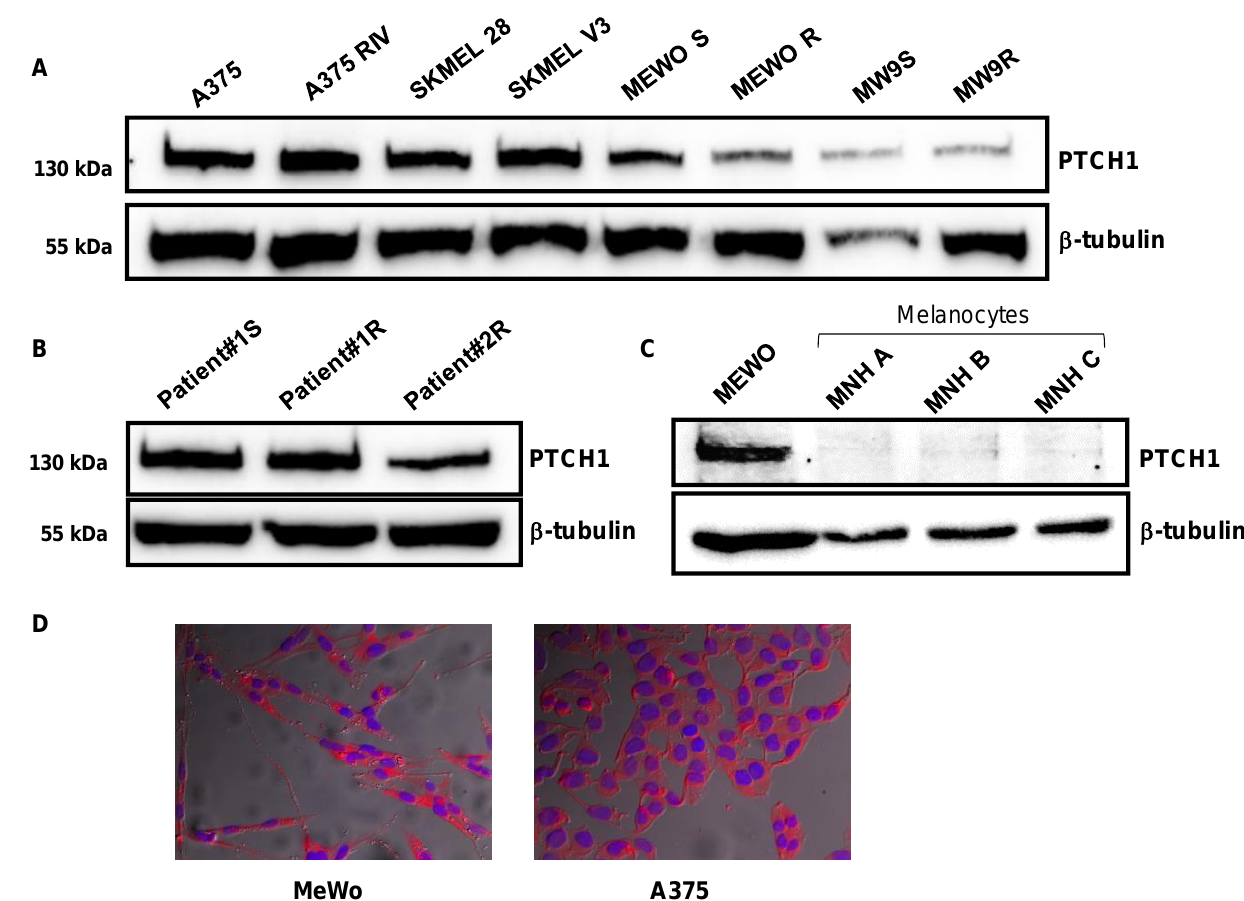
Figure 1. Ptch1 is expressed in various melanoma cell lines and in melanoma cells from patients. Western blots were performed on total extracts from several melanoma cell lines ( A ), melanoma cells from three patients sensitive or resistant to vemurafenib ( B ), and from melanocytes from three different primary cultures ( C ) using antibodies directed against Ptch1 and β -tubulin. ( D ) Immunofluorescence labeling of Ptch1 on MeWo and A375 cells with antibodies directed against Ptch1 (in red) and DAPI (in blue). Images were acquired with a fluorescence microscope using a 40× objective.